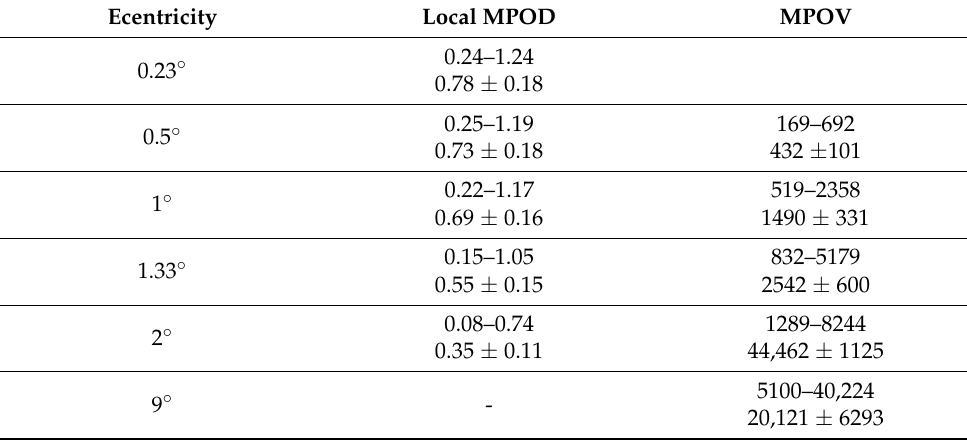
Table 3. Range and mean ± standard deviation of MPOD at five eccentricities and MPOV within five eccentricities.